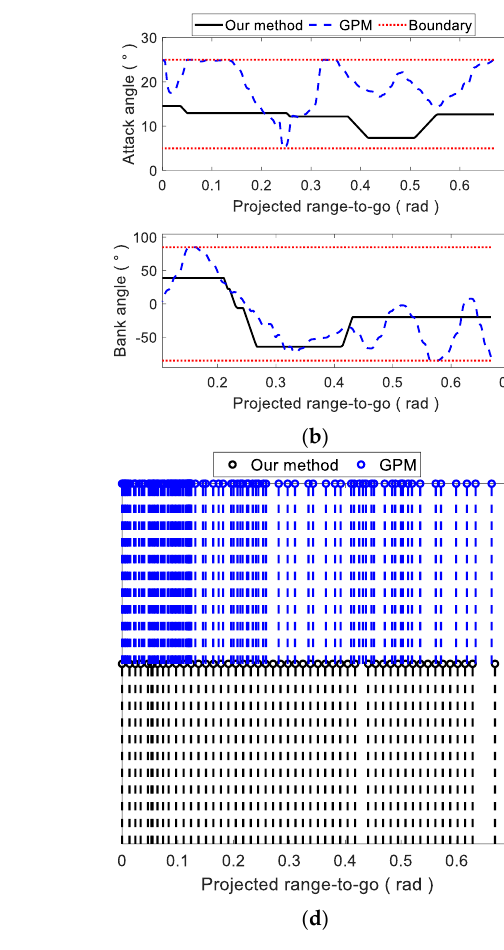
Figure 12. The comparison with GPM: ( a ) represents the lateral and longitudinal trajectories; ( b ) represents the control angle; ( c ) represents the processing constraints; ( d ) represents the grid points of the methods. Table 4. Generation effect of different methods.